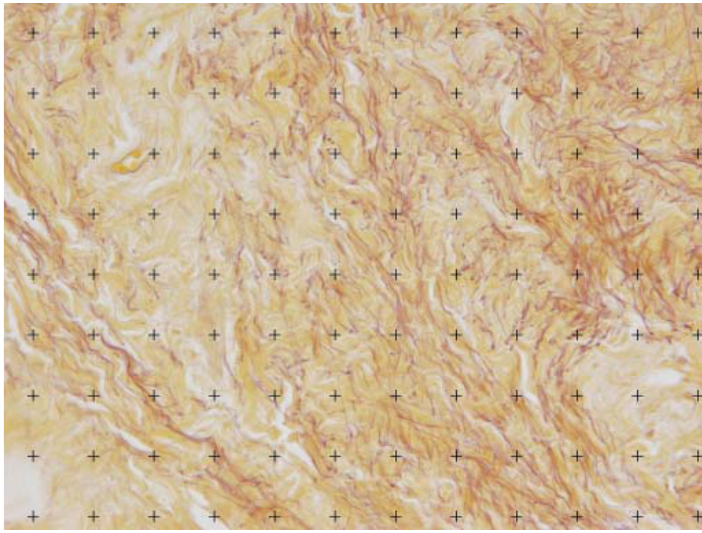
Figure 1 - Quantifi cation of elastic fi bers: The quantifi cation was obtained using the M42 Test system. Photomicrograph of the prepuce of an 8-year old patient of the control group (without treatment). Weigert stain reduced from